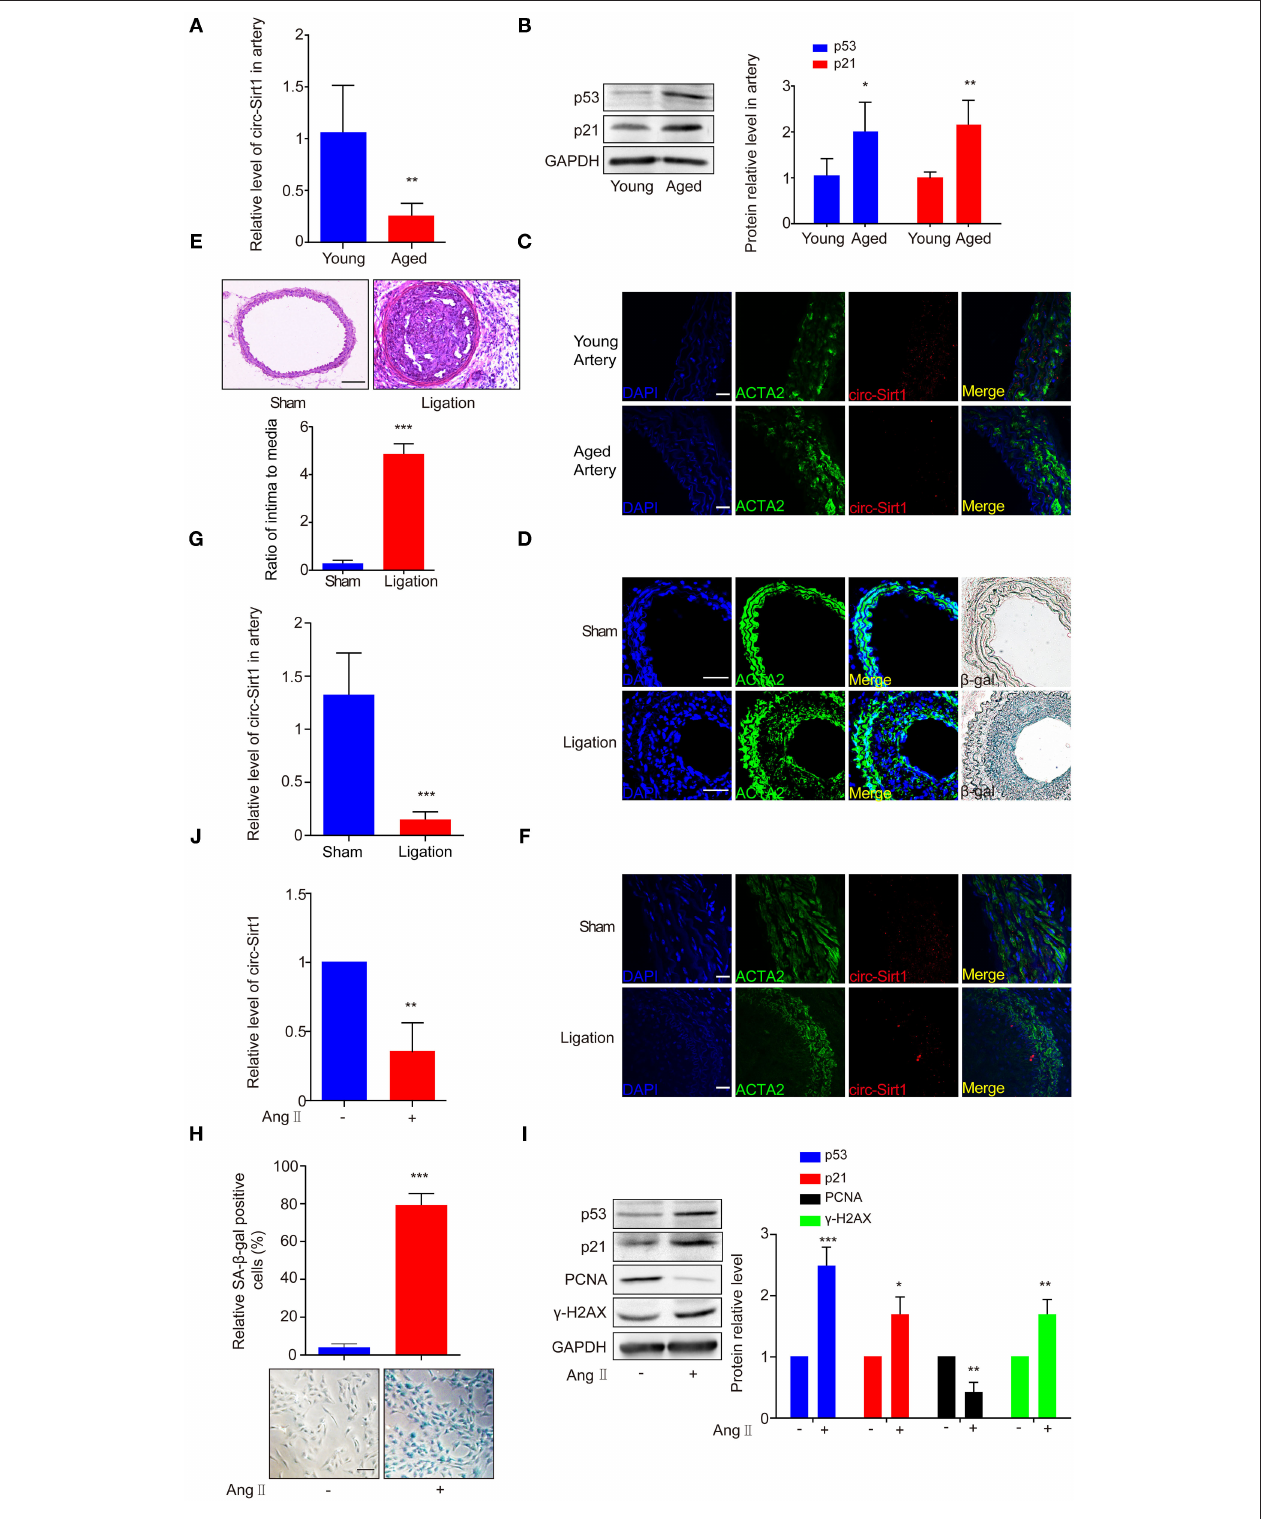
FIGURE 1 | The expression of circ-Sirt1 is decreased in the arteries of aged mice and the neointimal hyperplasia. (A–C) qRT-PCR for circ-Sirt1 expression (A) , Western blot for p53 and p21 (B) , and representative co-localization analysis of circ-Sirt1 with the VSMC marker ACTA2 by fluorescent in situ hybridization in